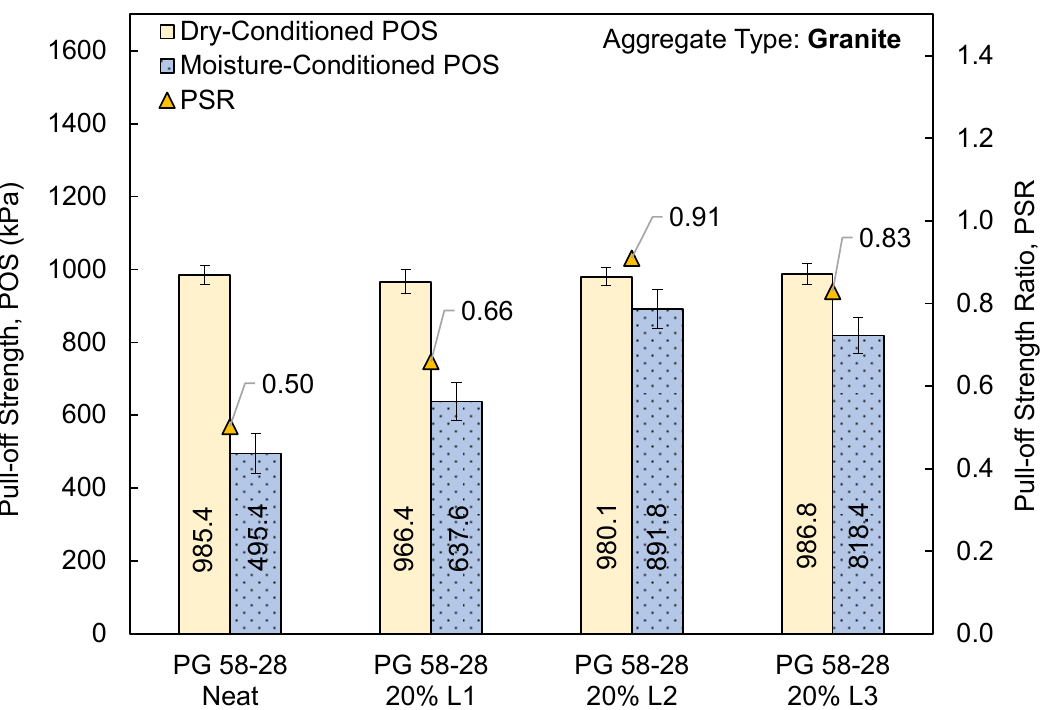
Figure 10. Average POS Dry , POS Wet , and PSR Values of Binder Blend with Granite Aggregate. It was observed that the measured POS Dry value of the samples prepared using neat PG 58-28 asphalt binder with granite (985.4 kPa) reduced by 2%, 1%, and 0%, after incorporating 20% L1, 20% L2, and 20% L3, respectively. Given the variability of the measured POS Dry values, as shown by the error bars in Figure 10, it can be concluded that the POS Dry value of the neat binder with granite remained statistically unchanged as a result of blending it with 20% L1, 20% L2, and 20% L3. Therefore, the resistance of